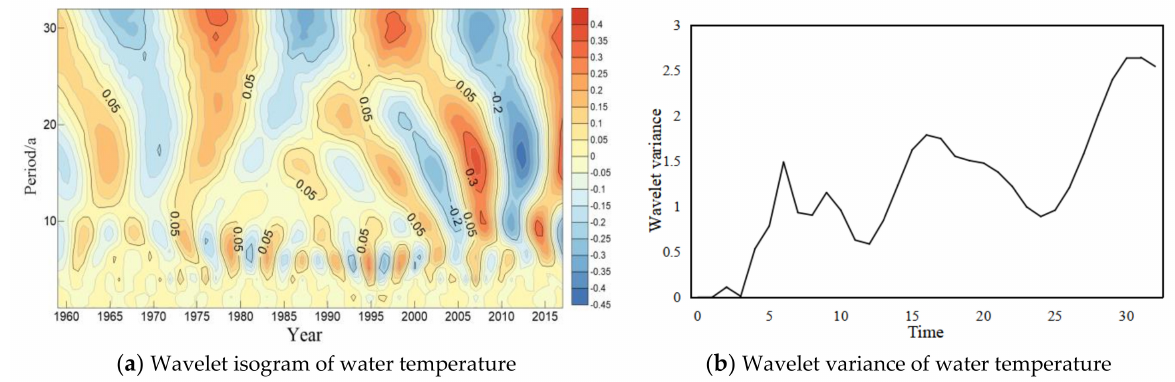
Figure 7. Wavelet isogram ( a ) and wavelet variance map ( b ) of water temperature at Datong